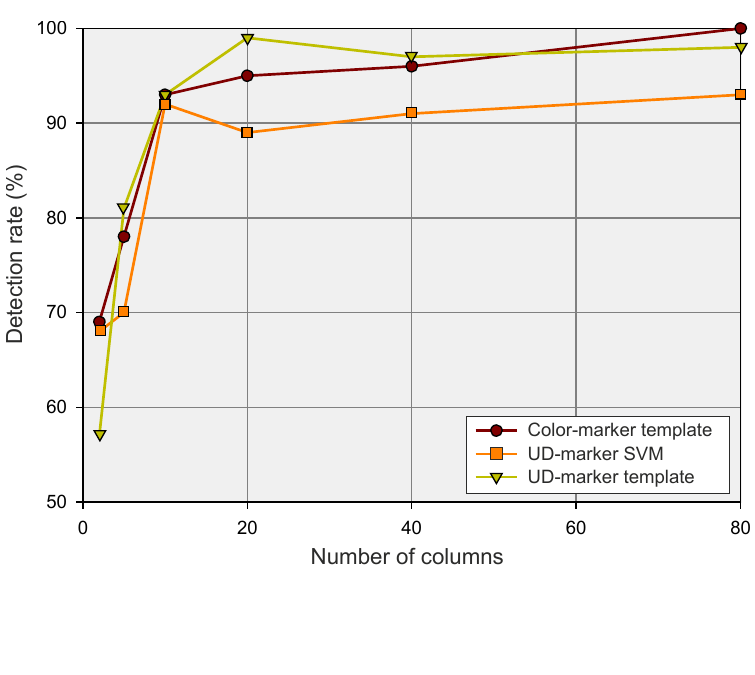
Figure 25. Trade-off consideration between the detection quality and the number of columns: the detection rate (%) depends on the number of salient columns as input for the marker detection algorithms Color-Marker_Template , UD-Marker_SVM and UD-Marker_Template